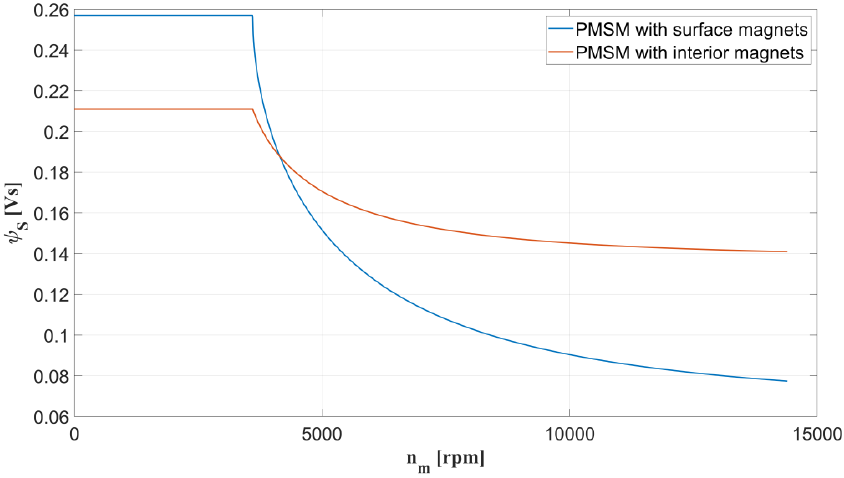
Figure 4. Ideal stator flux characteristics for two-zone PMSM control.